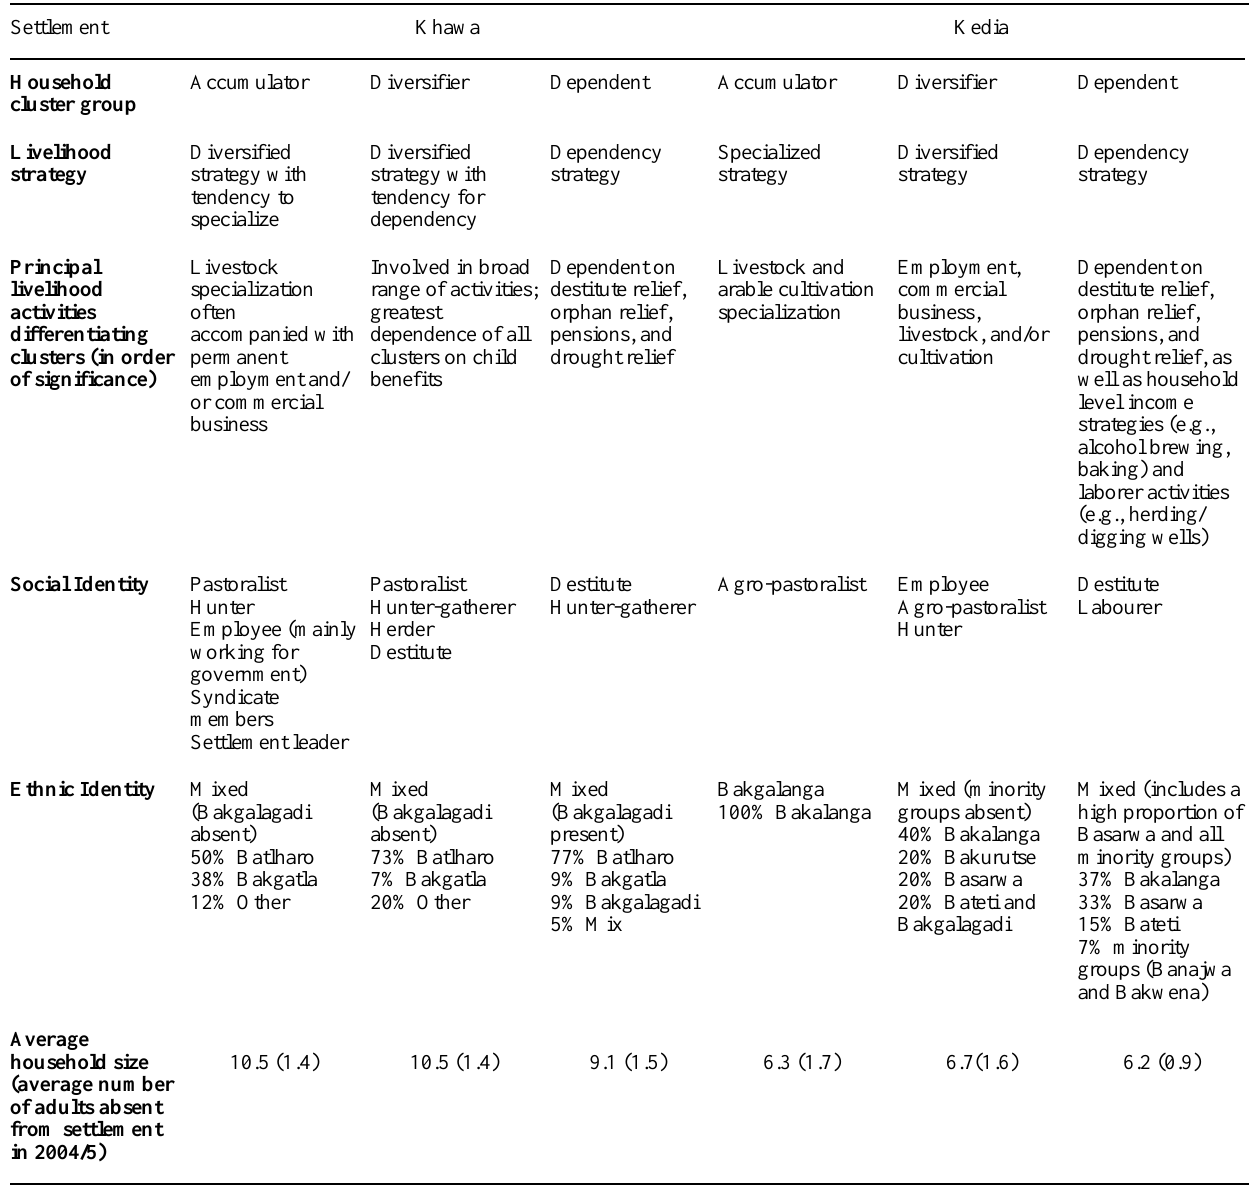
Table 3 . Livelihood strategies associated with household cluster groups, and the principal activities determining each strategy for Khawa and Kedia in 2004 and 2005. Principal activities were identified using principal components analysis. Differentiation of livelihood activities between cluster groups was more significant (clear cut) in Kedia than in Khawa, with a greater proportion of the cumulative percentage of total variance explained in Kedia than in Khawa at each level of